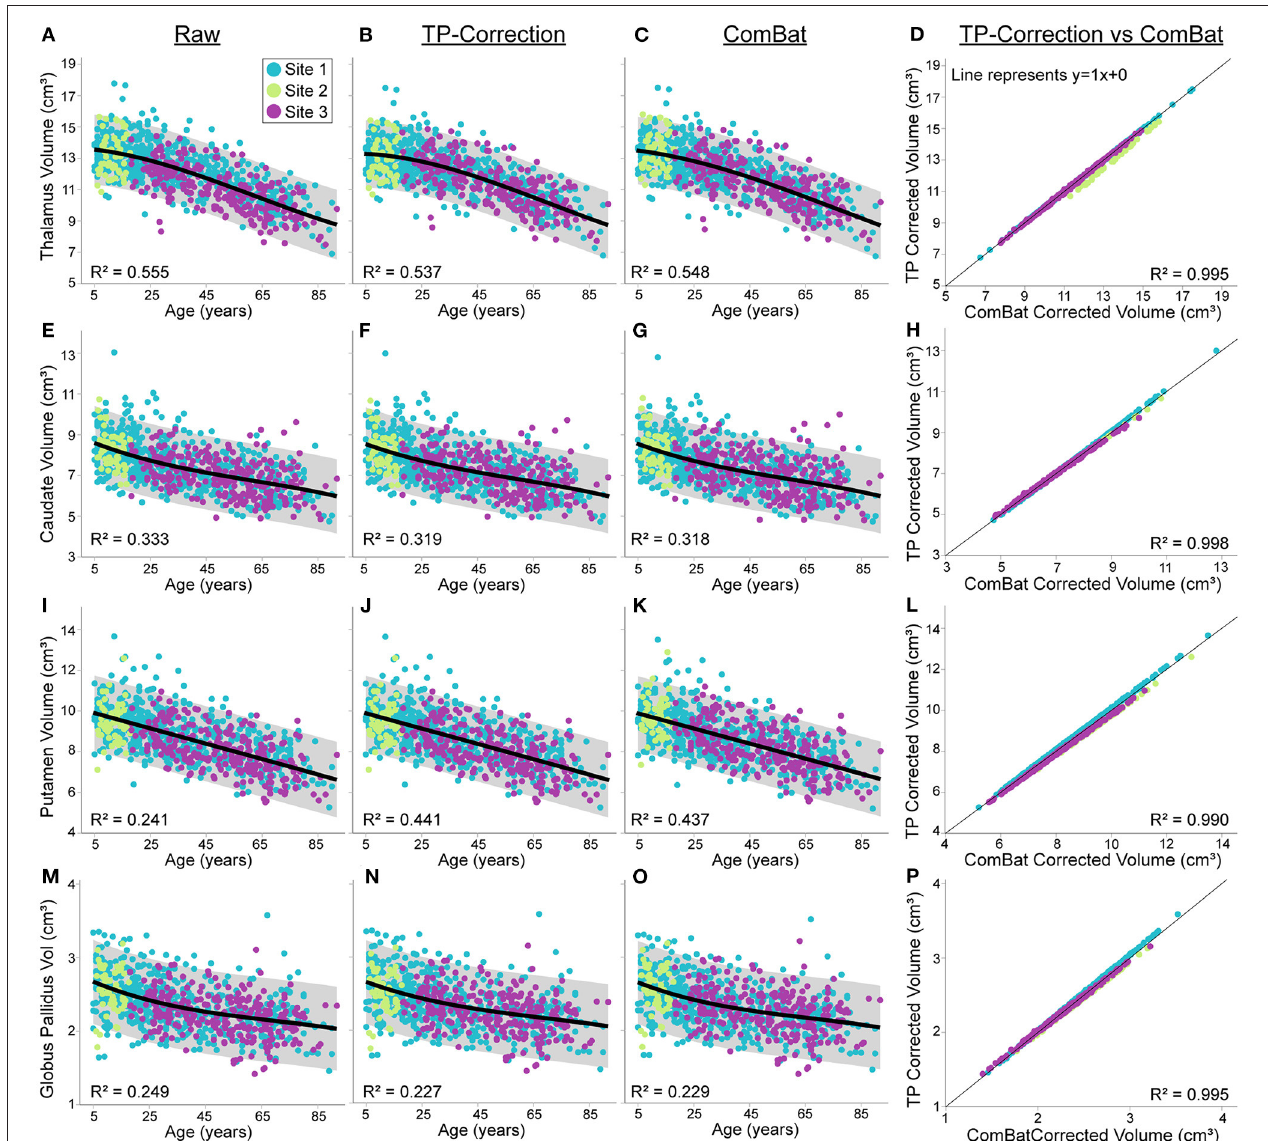
FIGURE 5 | Thalamus, caudate, putamen and globus pallidus volume trajectories in 856 healthy participants (5—91 years of age) scanned at the three sites [Site 1 (UofA) – blue, Site 2 – (ACH) – light green, Site 3 (FMC) – purple] before (column 1) and after traveling phantom based (column 2) or ComBat site correction (column 3). All volumes were lower at older ages, following either linear (putamen) or cubic trajectories (caudate, thalamus and globus pallidus). Gray shaded areas represent the 95% confidence interval of each fit. Traveling phantom corrected volumes and ComBat corrected volumes were highly correlated in all structure, following a similar pattern at all 3 sites (column 4). Trajectories and correlations are shown for thalamus (A–D) , caudate (E–H) , putamen (I–L) , and globus pallidus volumes (M–P) .